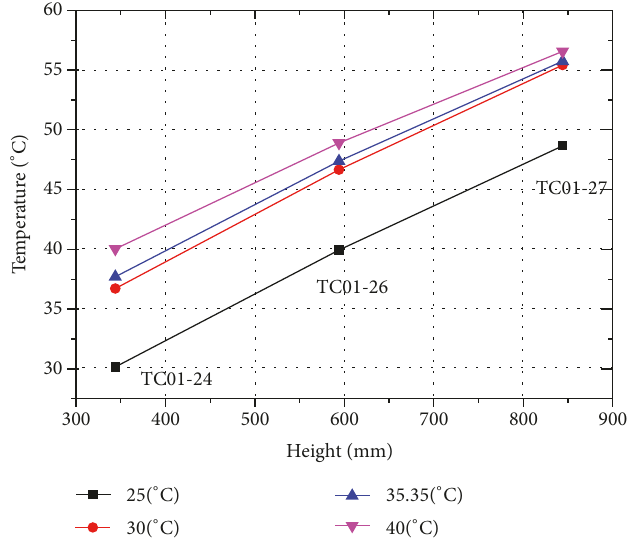
Figure 15: The effect of inlet cooling air temperature on support front